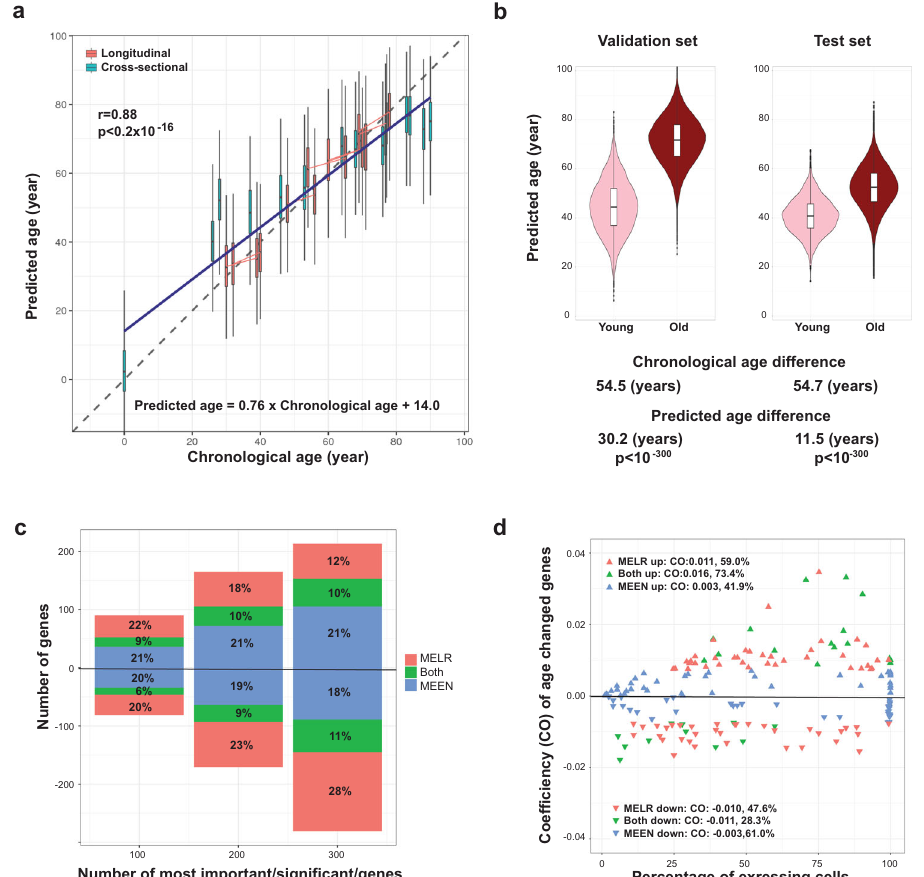
a and b :thecenterlineisthemedian;theboxisfromthe25 th tothe75 th percentile. The upper or lower whisker extends from the hinge to the 1.5 x IQR (distance betweenthe fi rstand thirdquartiles)from thehinge forup andlow,respectively. P values were calculated by 2-sided T-test. The data are in Supplementary Data 5b. c Overlapofage-associatedgenesinCD8 + TcellsbetweenMELRandMEENmodels. Thepercentagesofoverlapswereincrementedbythetop100,200,and300genes identi fi ed by MELR based on FDR and coef fi cient of age. Percentages are grouped by if the genes were up or downregulated across aging as identi fi ed by the MELR method.The dataare inSupplementaryData5c. d Scatter plot of the coef fi cient of age (CO) of age-associated genes identi fi ed by MELR and the percentages of cells expressingeachgene.Theaveragechange (CO)and percentageofeachsixgroups are